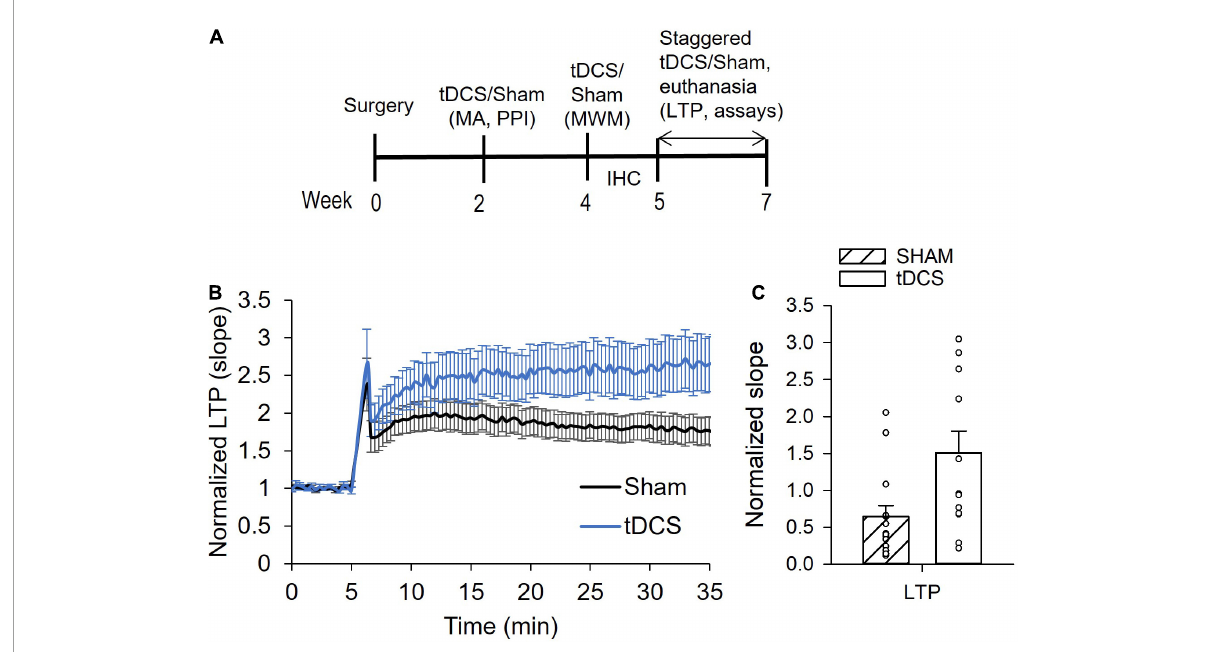
FIGURE1 Effects of transcranial direct current stimulation (tDCS) on hippocampal long-term potentiation (LTP). (A) Diagram showing the experimental timeline. Rats underwent surgery and 3 rounds of tDCS before LTP and cytokine levels were measured. (B) Normalized slope data showing tDCS effect on LTP. Administration of tDCS resulted in enhanced LTP in the Shaffer collateral-CA1 synapses of rat hippocampus. (C) Bar graph showing significant increase in LTP from rats given 3 rounds of tDCS ( p = 0.009, n = 15 slices sham, n = 13 slices tDCS, Mann